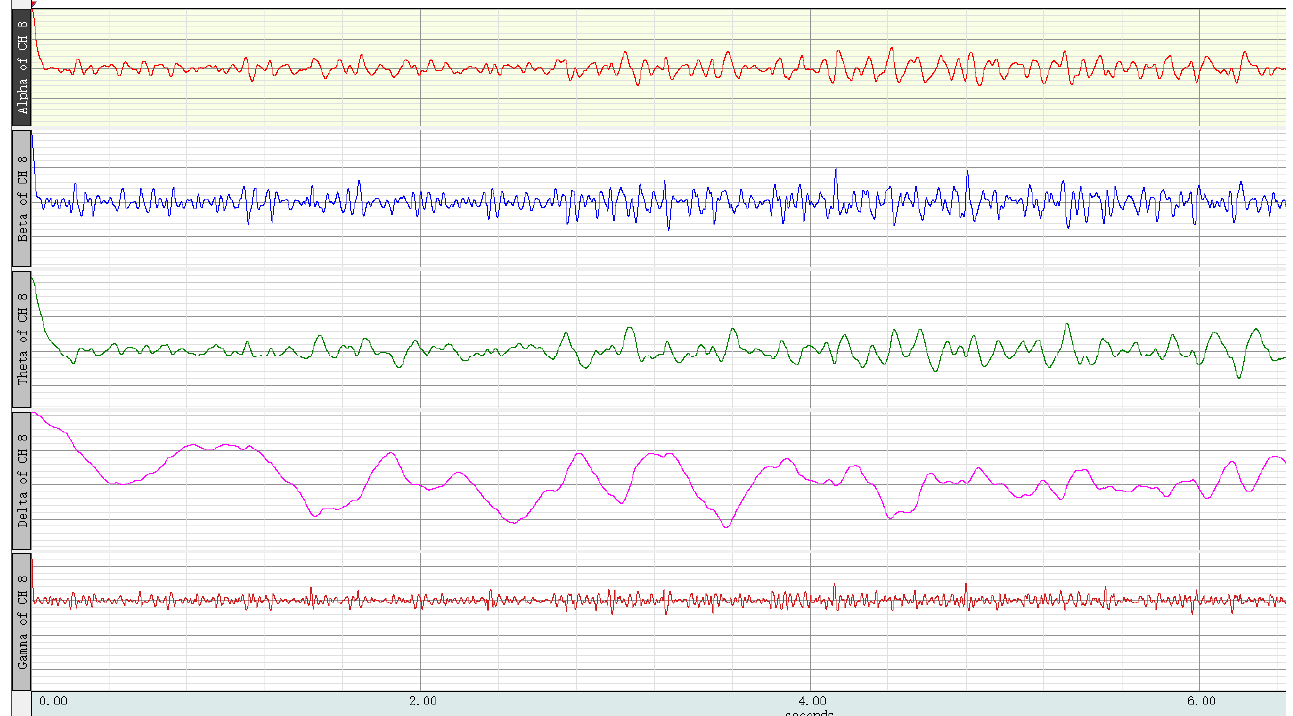
Figure 17. Example of EEG waveforms at various frequency bands.